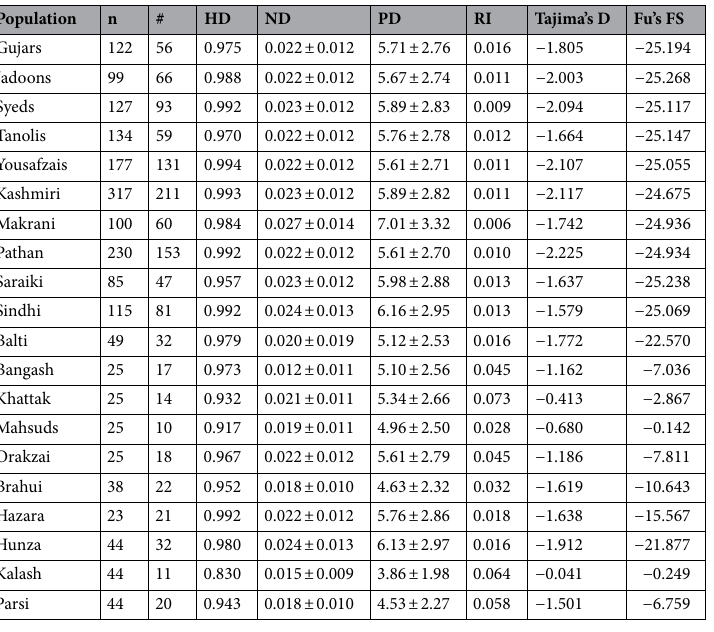
Table 1. Summary statistics for KPP ethnic groups and other Pakistani populations based on mtDNA HVS-1 haplotypes. n = number of samples; # = number of haplotypes; HD: Haplotype Diversity; ND: Nucleotide Diversity; PD: Pairwise differences; RI: Raggedness index; Citations and references for the comparative populations are provided in Table